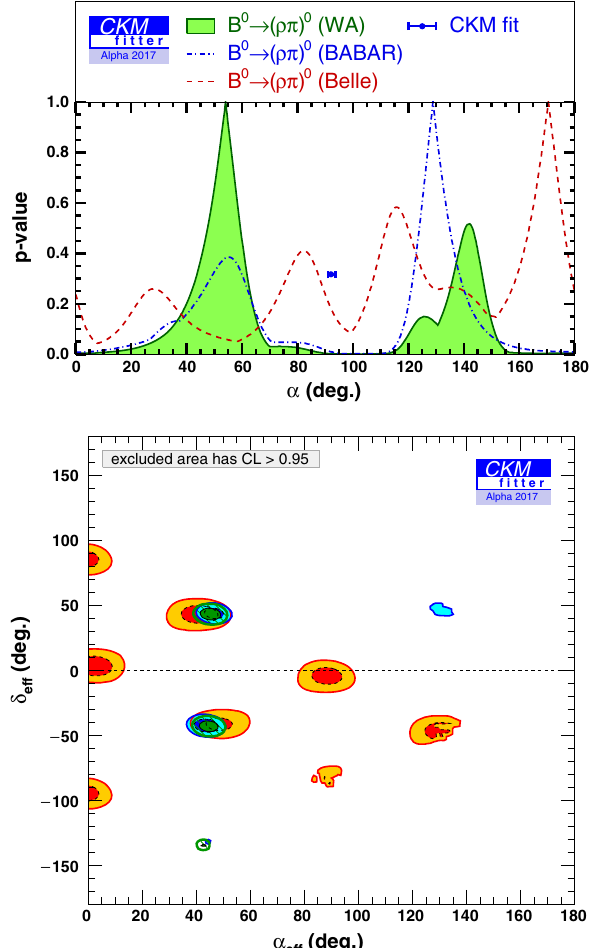
Fig. 49 Constraint on α from the SU ( 2 ) isospin analysis of the B 0 → (ρπ) 0 system ( top ) using BaBar data ( blue curve ) and Belle data ( red curve ). The green shaded area represents the determination based on the world average. The interval with a dot indicates the indi- rect α determination introduced in Eq. (2). The bottom panel represents the two-dimensional constraint in the ( α eff , δ eff ) plane with the same colour code